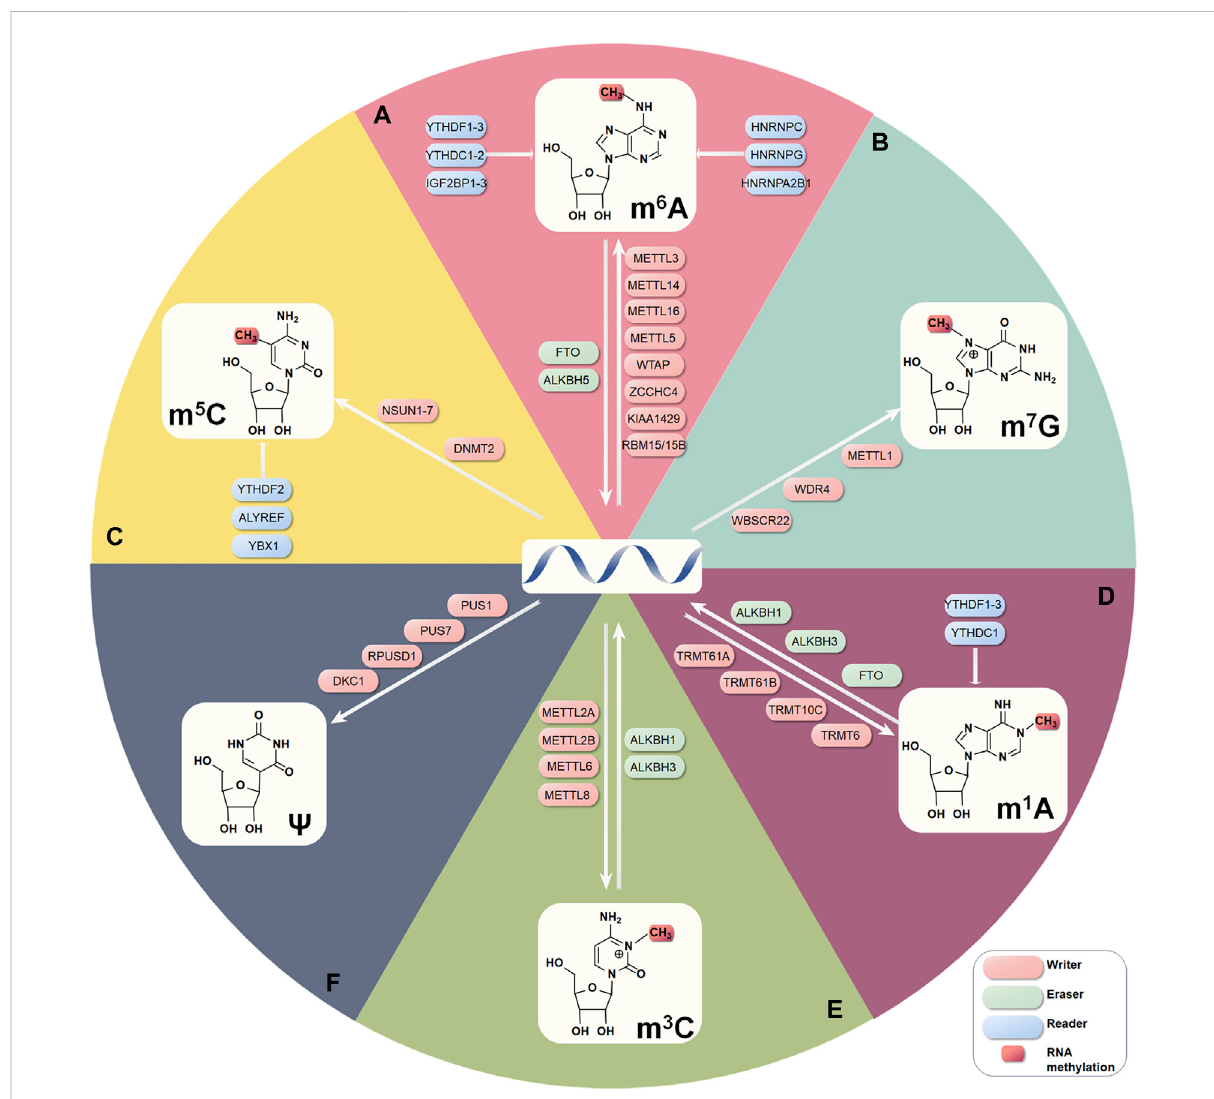
The six internal RNA modi fi cations focused on in this review and their regulatory mechanisms. (A) m6A. (B) m7G. (C) m5C. (D) m1A. (E) m3C. (F) Ψ